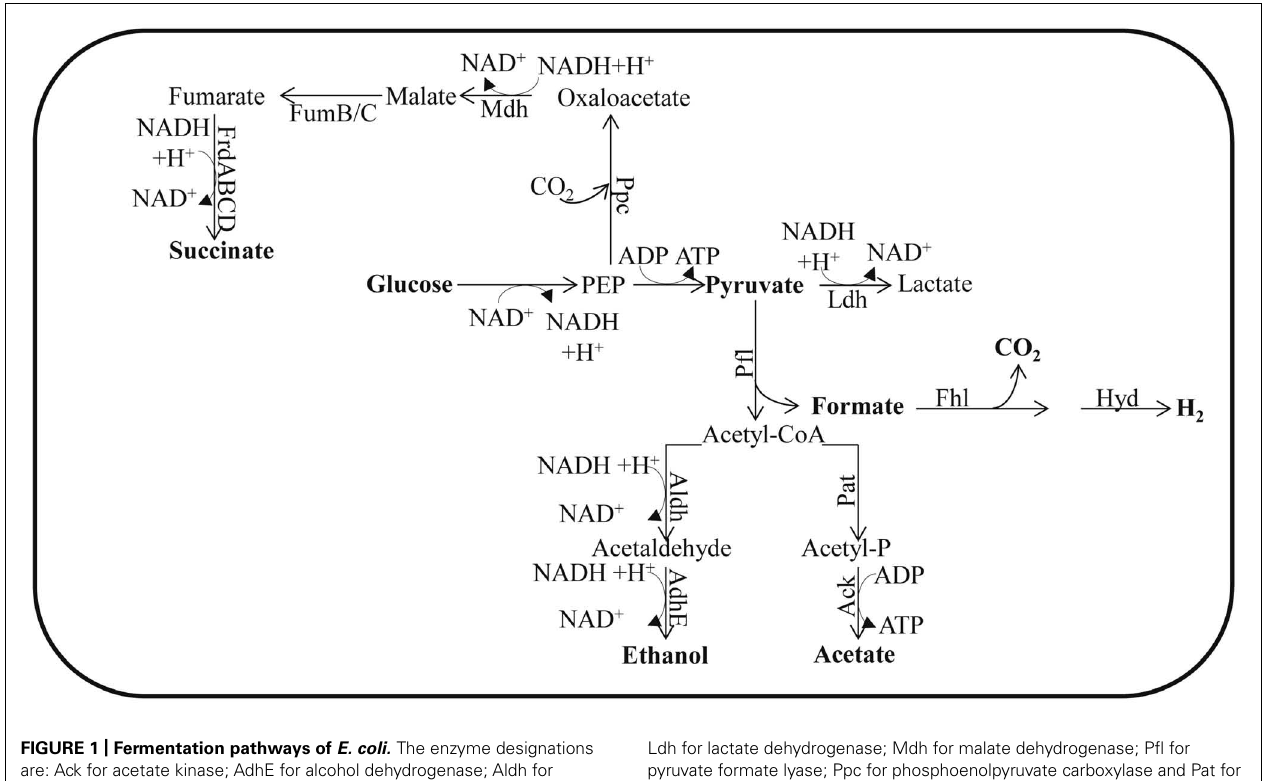
Ldh for lactate dehydrogenase; Mdh for malate dehydrogenase; Pfl for pyruvate formate lyase; Ppc for phosphoenolpyruvate carboxylase and Pat for phosphotransacetylase. In Chlamydomonas , Aldh and AdhE activities are fused in the enzyme ADH1.